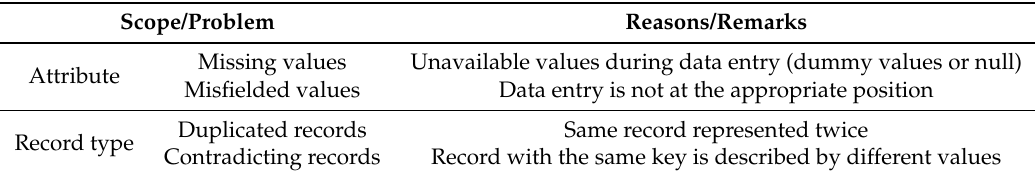
Table 4. Illustration of errors in SCADA data and status data.